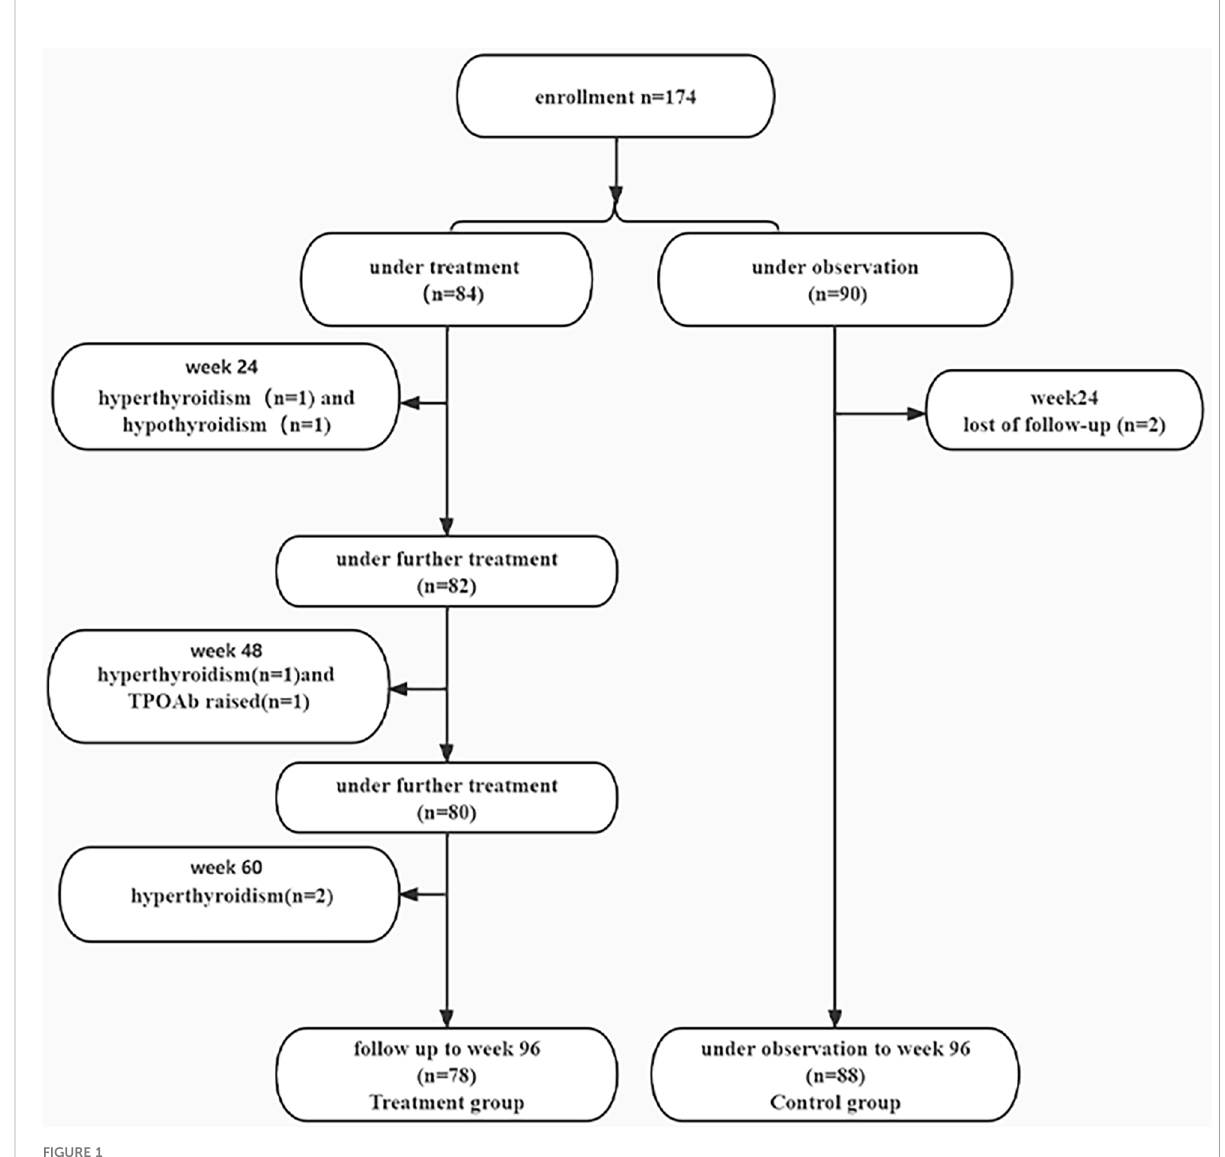
FIGURE 1 Flow diagram of participants enrolled in this